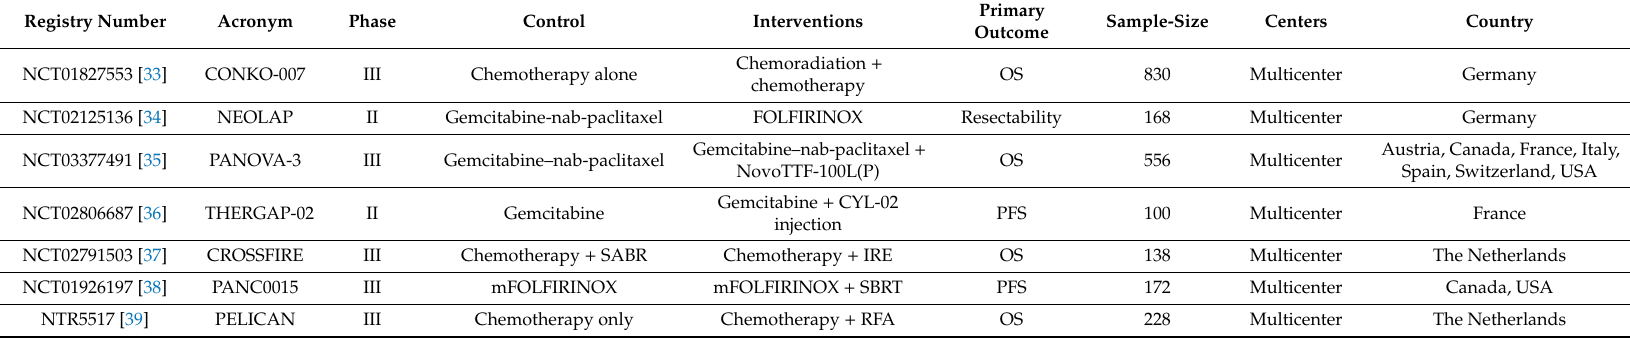
Table 1. Registered randomized phase II / III trials in locally advanced pancreatic cancer comprising > 100